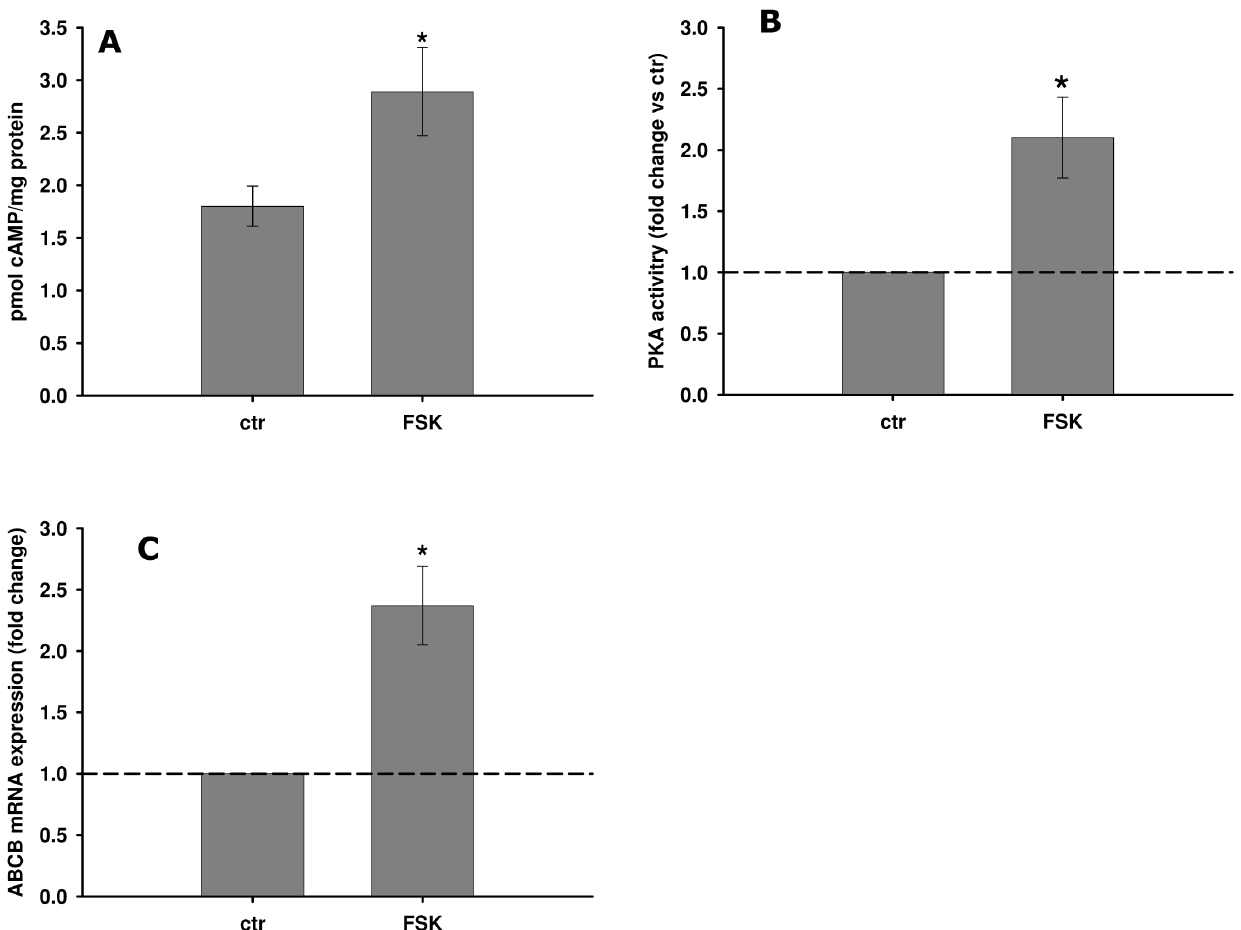
Figure 5. Effects of FSK on cAMP-related parameters and ABCB mRNA expression in mussel haemocytes incubated invitro . (A) cAMP content; (B) relative PKA activities; (C) relative ABCB mRNA expression. All biological endpoints were assessed after 4 h of exposure to 20 m M FSK. Data are derived from three independent experiments (mean 6 SEM); *p , 0.05 vs control. Basal PKA activity=1.12 6 0.17 nmol/min/mg protein.